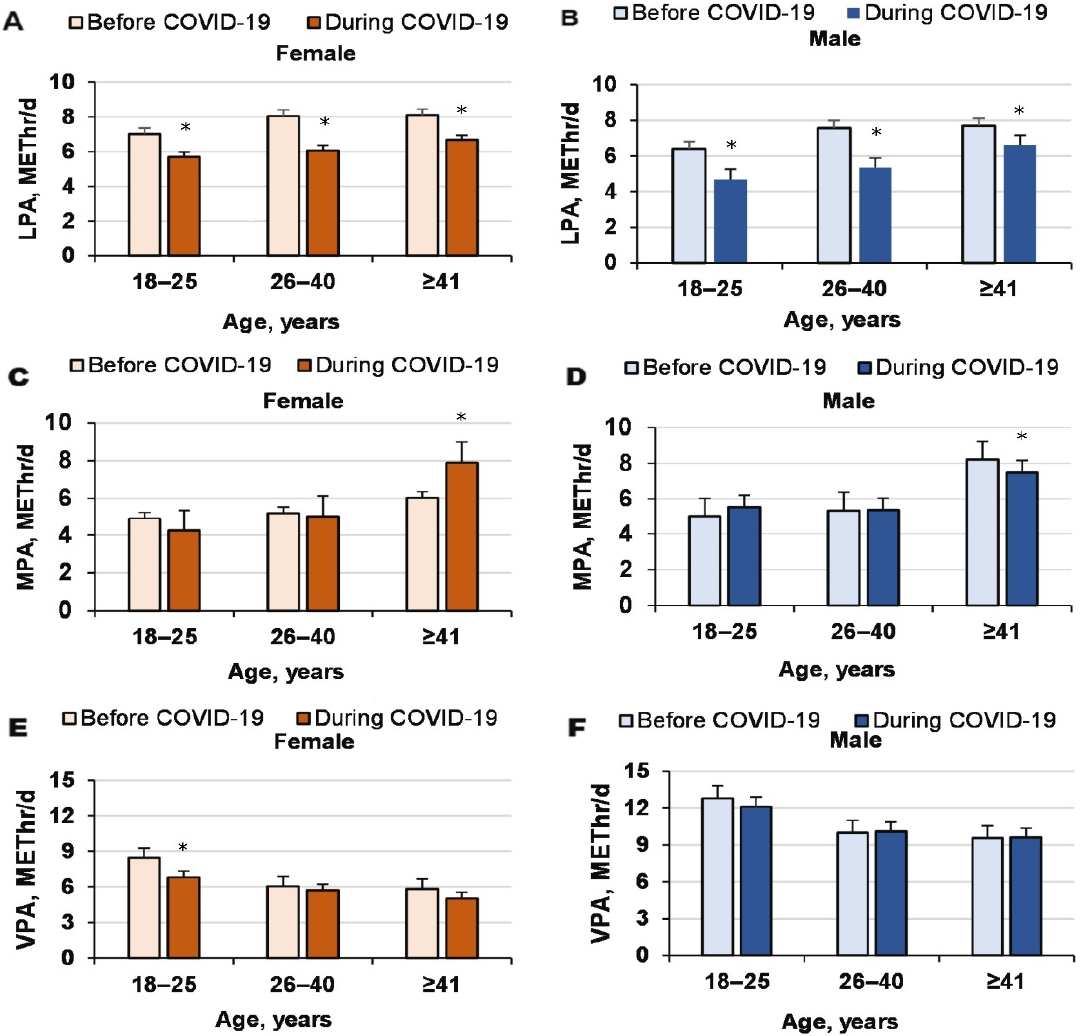
Figure 2. PA distributions before and during COVID-19 for men and women of different ages. * compared to before COVID-19.